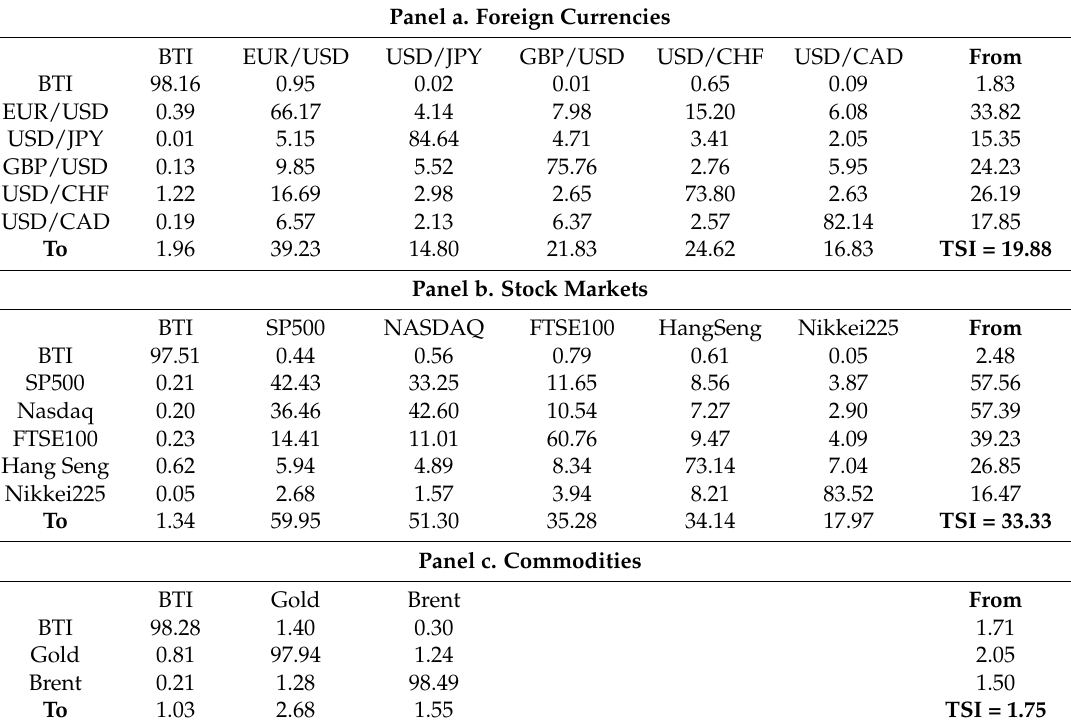
Table 3. Spill over effects between BTI, foreign currencies, stock markets and